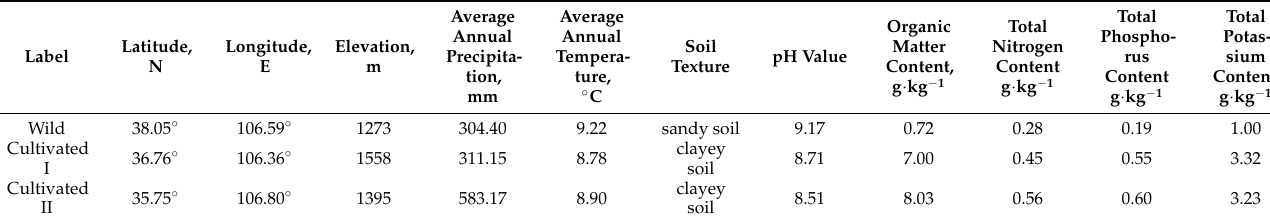
Table 1. Information of the collection